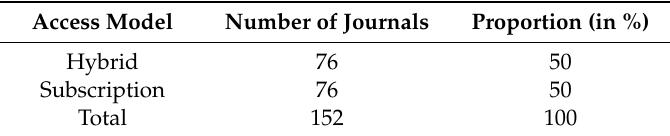
Table 4. Reverse-flip journals by access